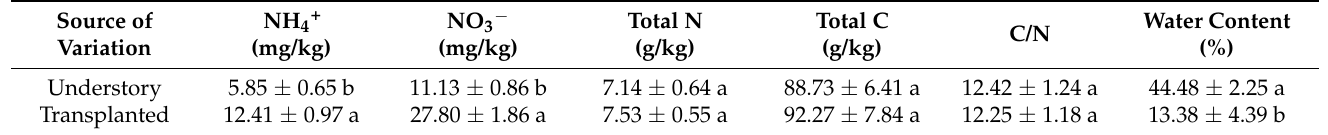
Table 1. Soil characteristics in undisturbed (understory) and disturbed (transplanted) sites, respectively.